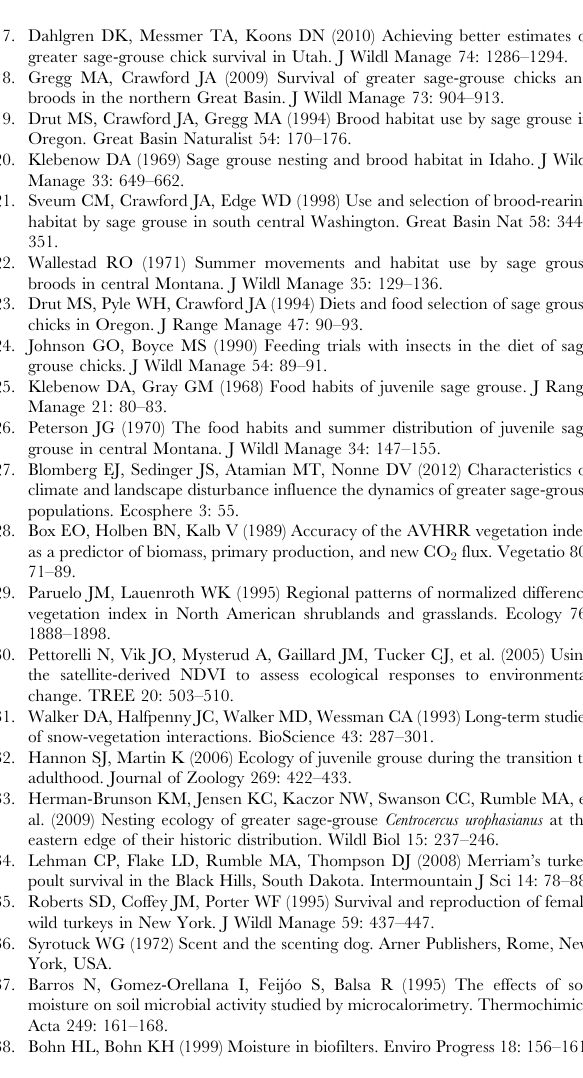
deviance relative to the base model (Quadratic Chick Age + Hen Age). Table S6 Parameter estimates with 95% confidence intervals for the top model of the effect of drought on greater sage-grouse chick survival. Confidence intervals were calculated based on 5,000 bootstraps of the original data set. Table S7 Models for the effects of climate on greater sage-grouse chick survival. Signs in parentheses indicate the direction of respective covariate effects excluding chick age. All models (except the intercept only model) contain the base effects of quadratic chick age and hen age. Models were evaluated using the Quasi-Akaike’s Information Criterion (QAIC). K = number of parameters. w i = model weight (i.e. the likelihood of a particular model being the best model). R-score =percent reduction of deviance relative to the base model (Quadratic Chick Age + Hen Age). Table S8 Parameter estimates with 95% confidence intervals for the top model of the effects of climate on